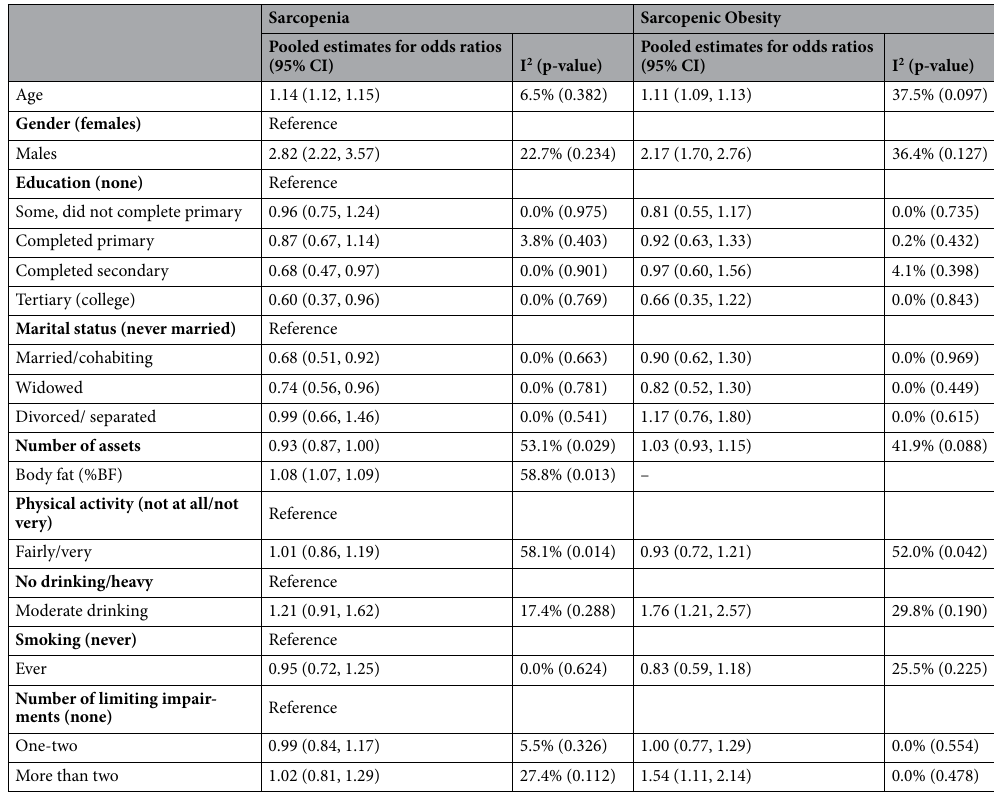
Table 4. Aggregated associations of sarcopenia and sarcopenic obesity. Models were adjusted for dementia, depression, diabetes and